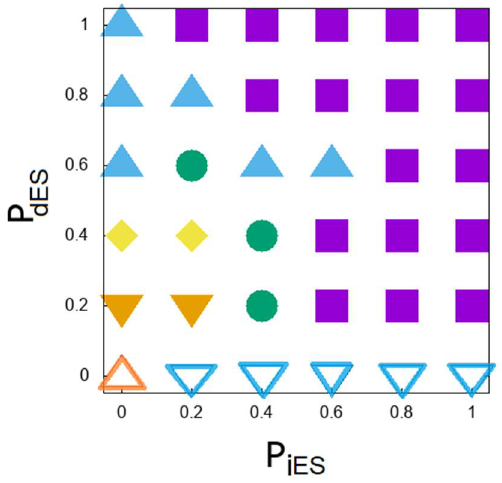
Figure 6. Diagram of pattern formation. Different symbols correspond to different patterns: de- scribes regular step ordering, means bunches, bunches with antibunches, describe nano- pillars, nanowires, pyramids, and is specific (0, 0) point.